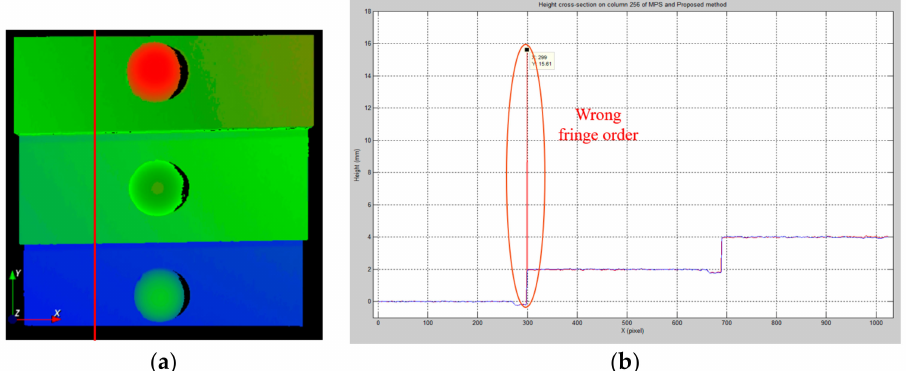
Figure 11. Comparison of fringe-order determination and phase ambiguity for a step-height target measured using ( a ) the MFPS algorithm and ( b ) the proposed fringe-order calculation algorithm.